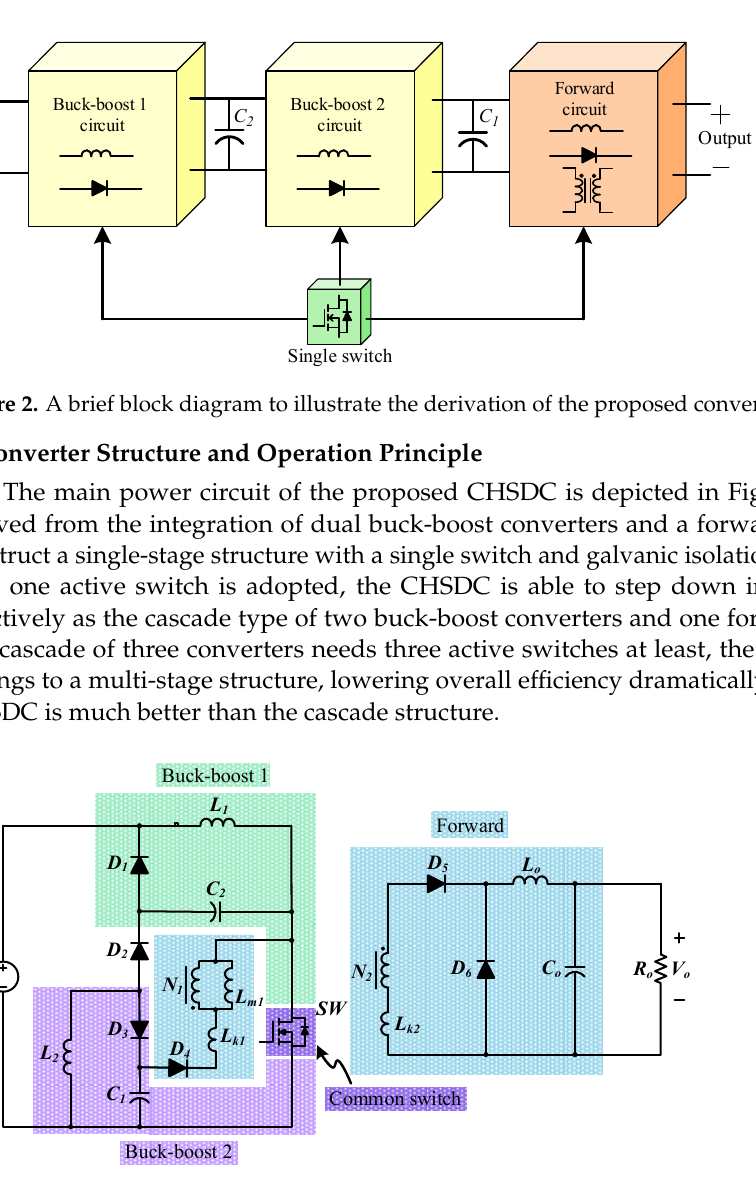
Figure 2. A brief block diagram to illustrate the derivation of the proposed converter.